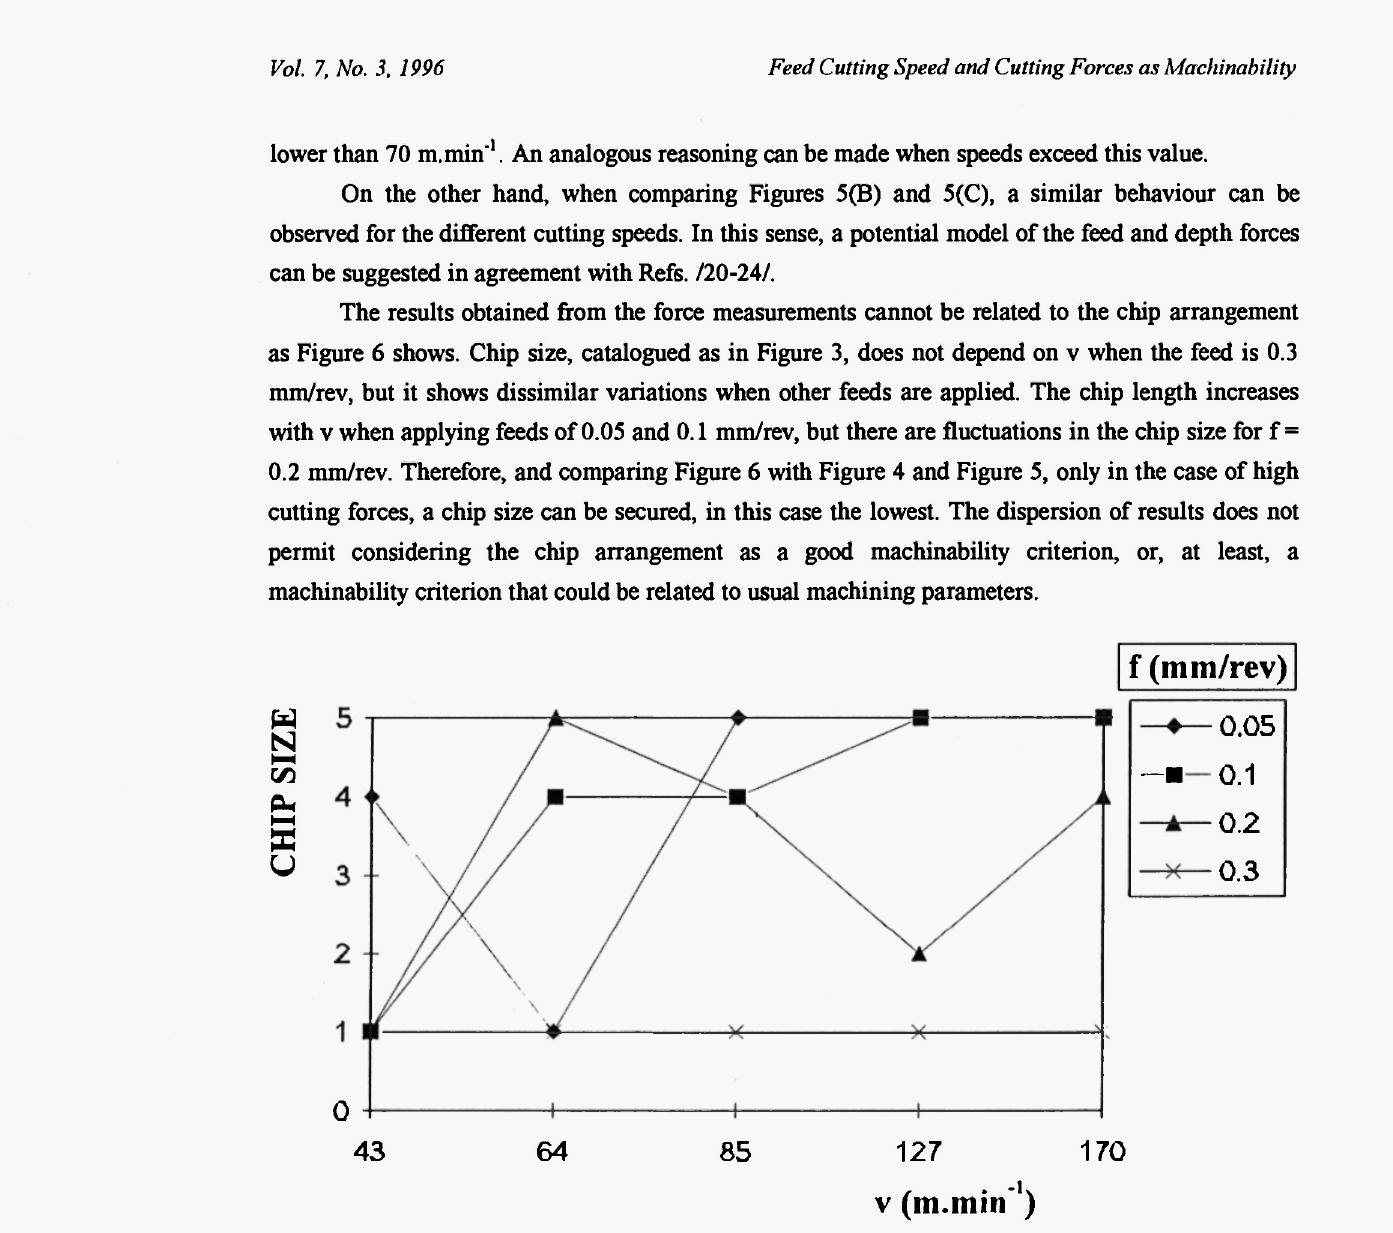
Fig. 6: Chip size, as catalogued in Figure 3, versus cutting speed for the different feeds